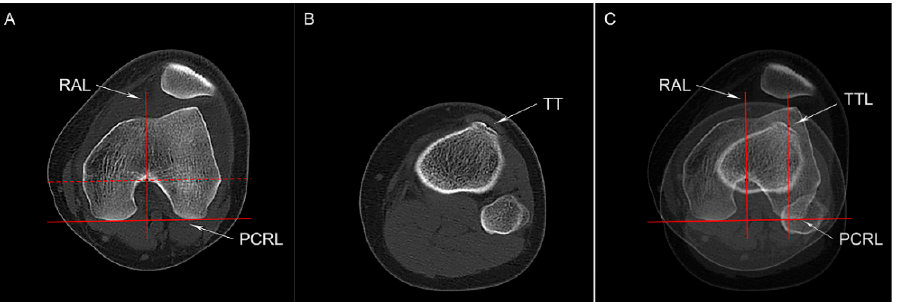
Figure 3. Tibial tubercle to Roman arch (TT-RA) distance. ( A ) The PCRL was drawn tangent to the posterior femoral condyles, and its parallel line (the doted one) was tangent to the Roman arch; a line perpendicular to the PCRL was drawn to pass through the tangent point (RAL). ( B ) The center of the tibial tuberosity (TT) is marked on an axial CT slice at the insertion of the patellar tendon. ( C ) After superimposing the two images, the line parallel to the RAL was drown through the TT (TTL). The TT-RA distance is defined as the distance between the RAL and the TTL.